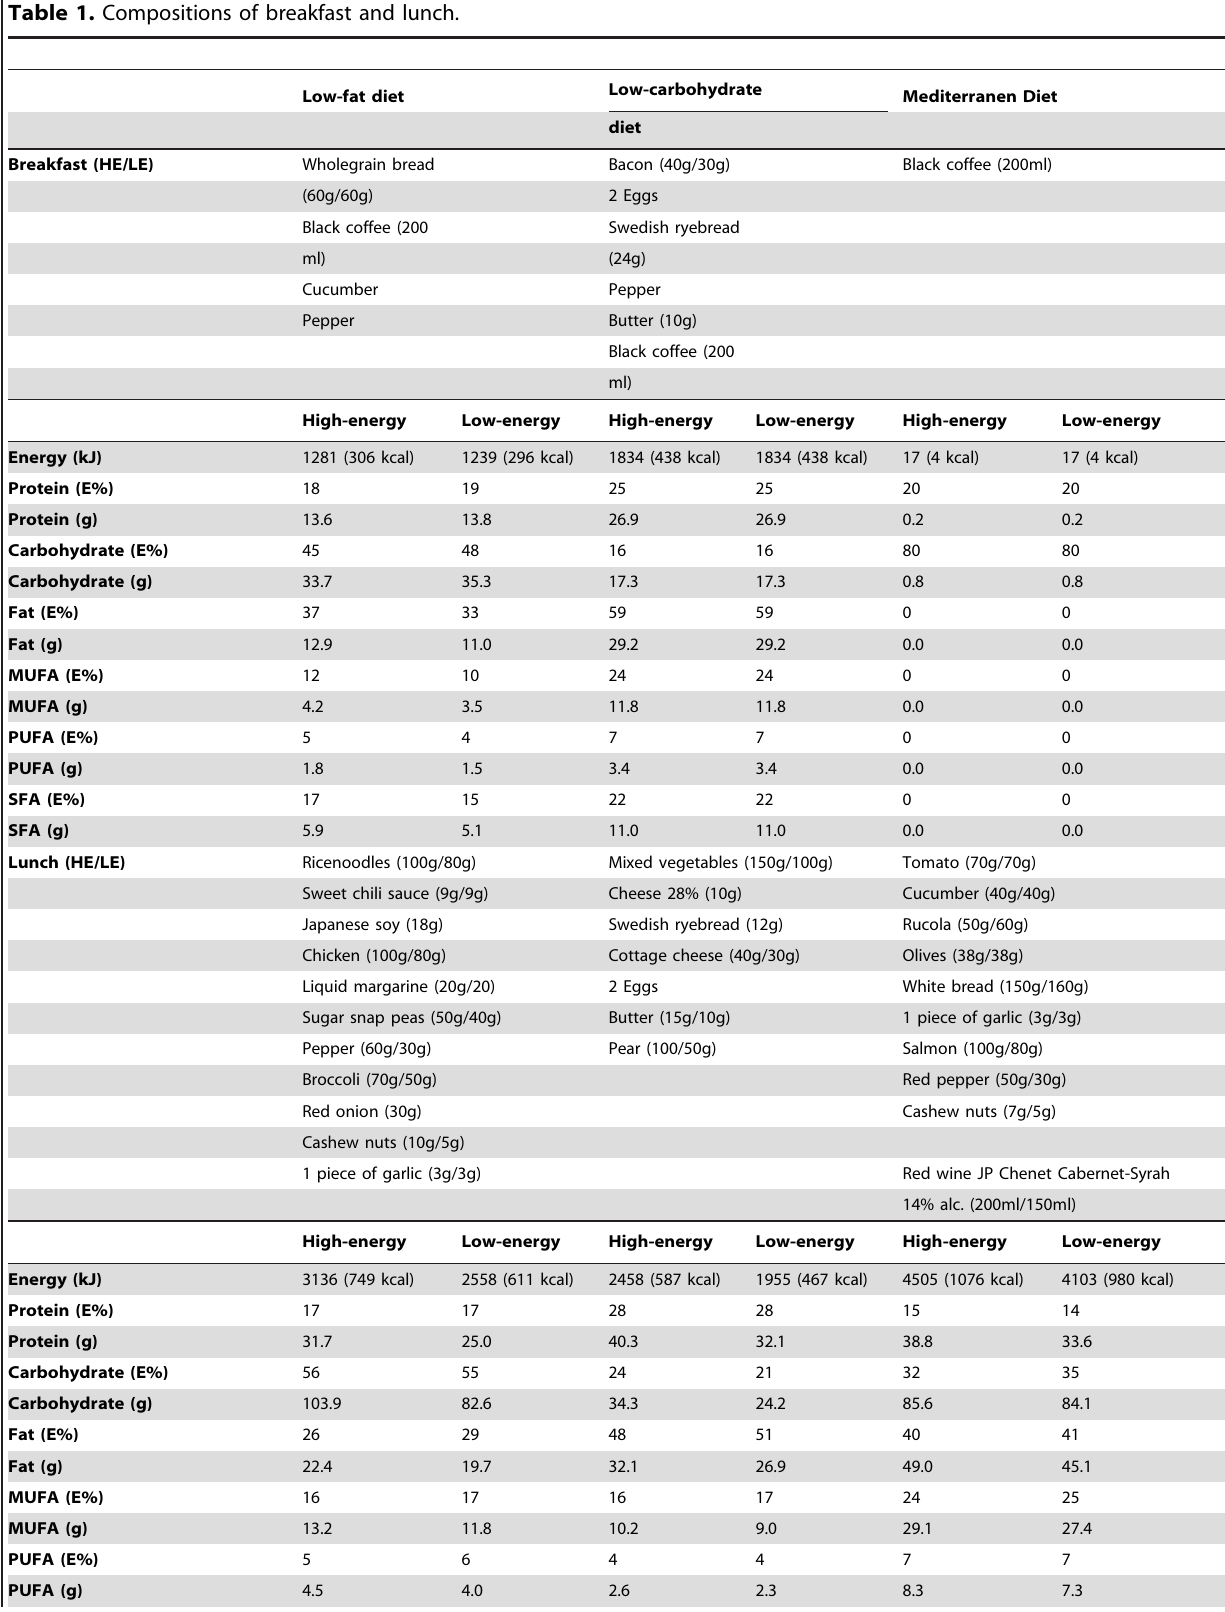
Table 1. Compositions of breakfast and